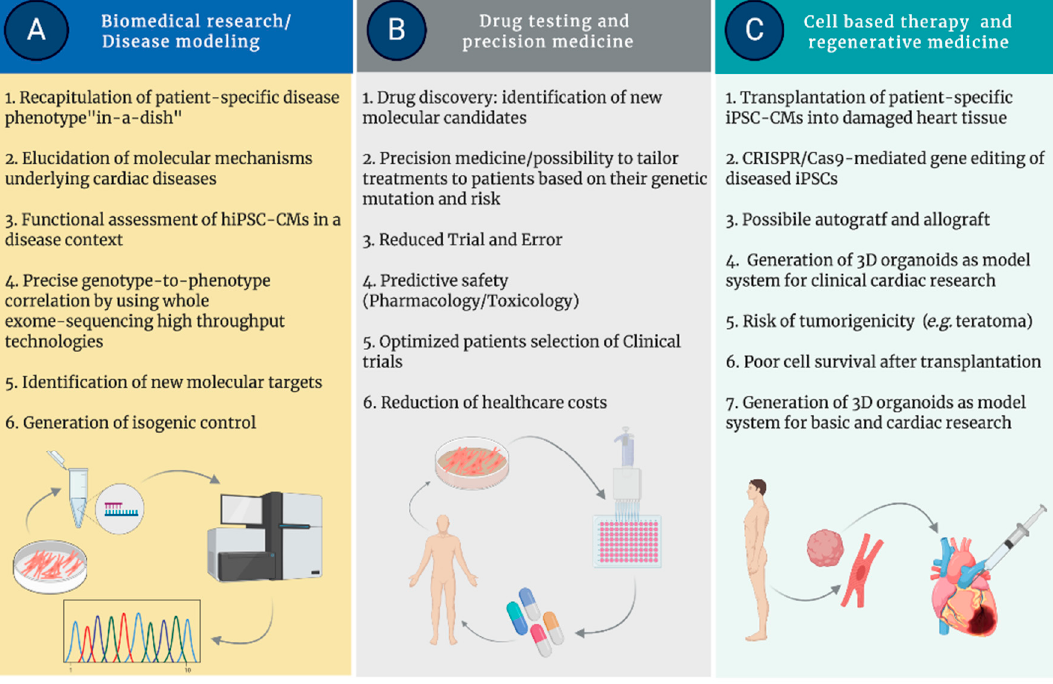
Figure 2. Major applications of iPSCs in research and medicine.